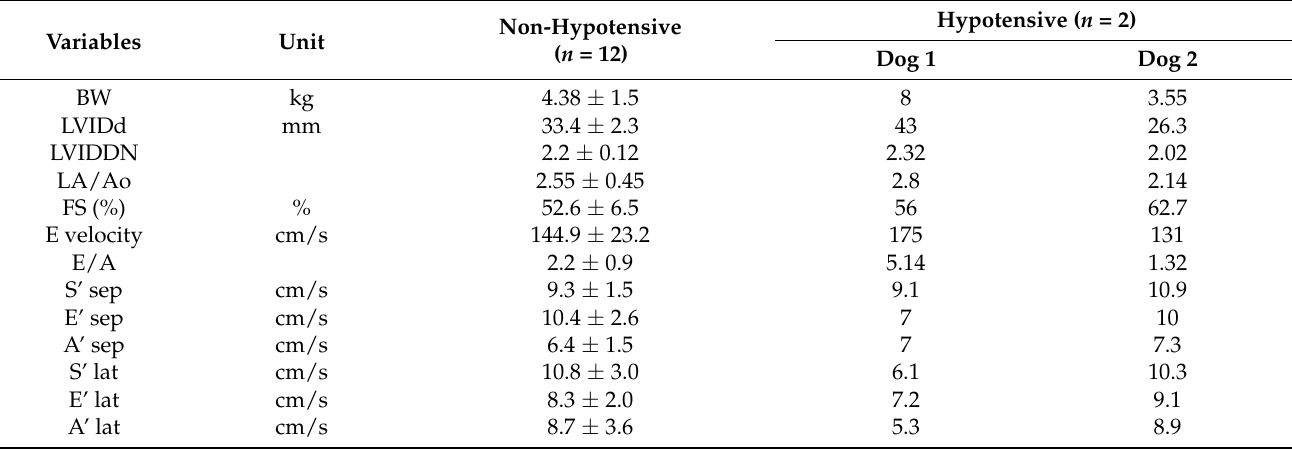
Table 2. Conventional echocardiographic variables before mitral valve